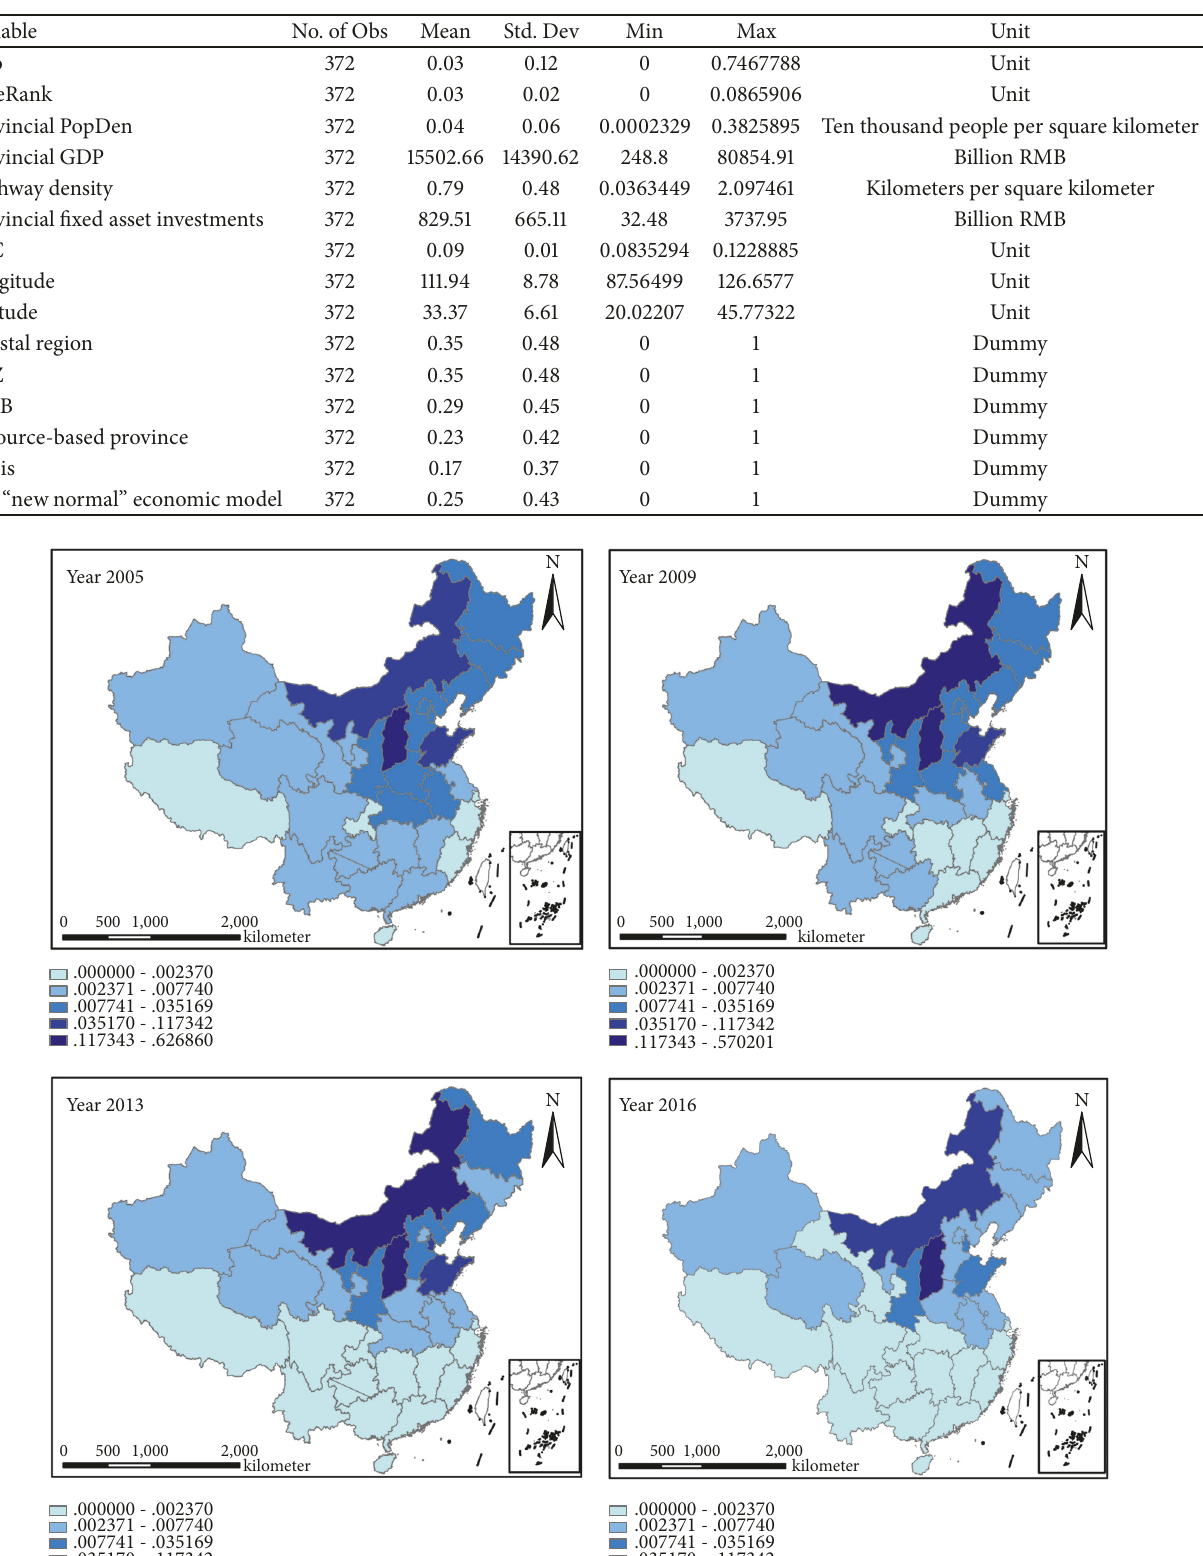
Table 2: Descriptive statistics of the variables.